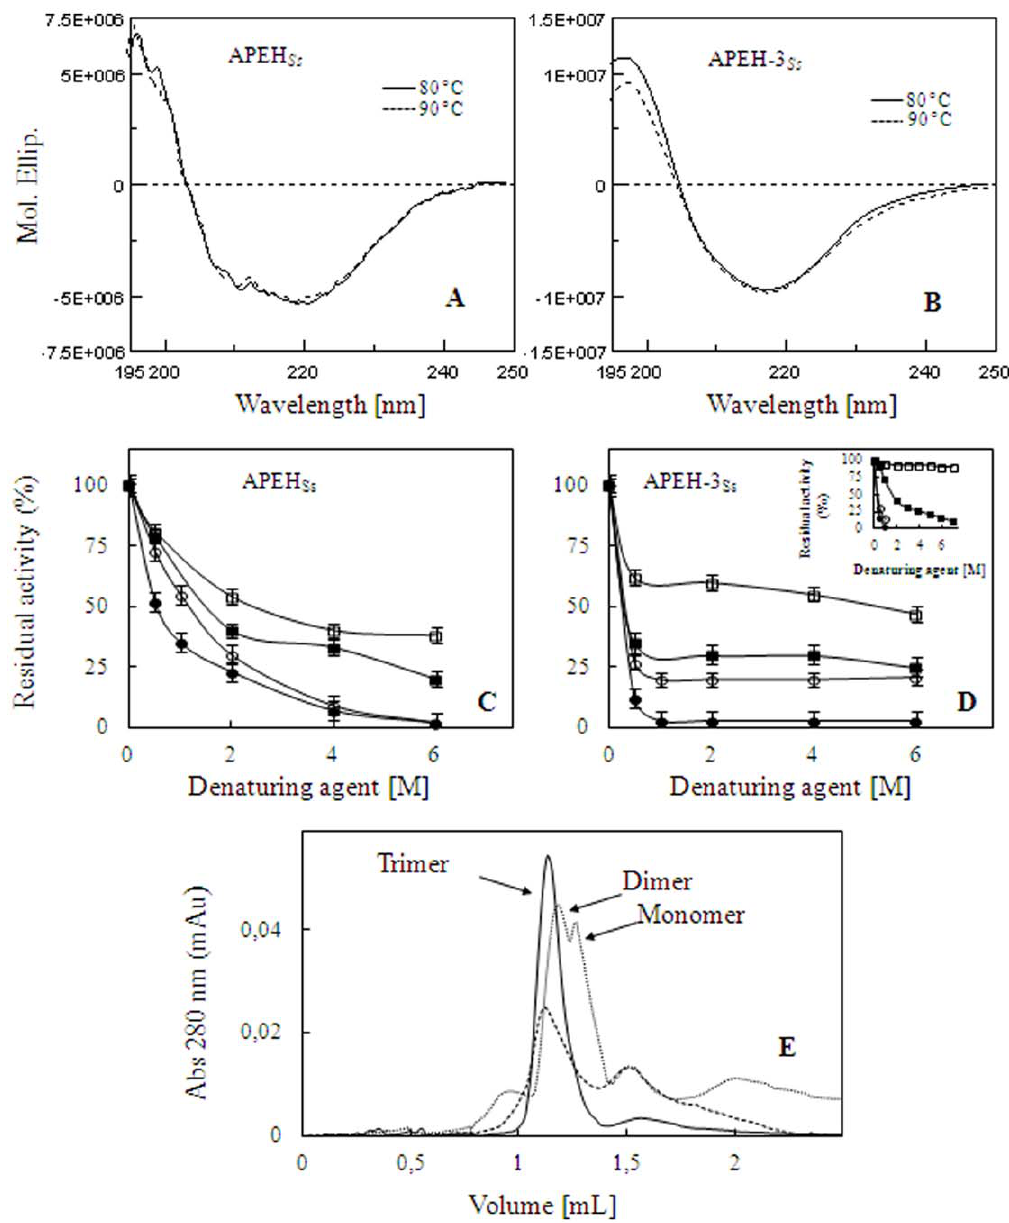
Figure 3. APEH structure and function analysis. ( A ) CD spectra performed at 80 u C and 90 u C for APEH Ss or ( B ) APEH-3 Ss , respectively. ( C ) Effect N of chaotropic agent on APEH Ss , and ( D ) APEH-3 Ss : the enzymatic activity was measured using Ac-A- p NA for APEH-3 Ss and Ac-L- p NA for APEH Ss as ); the activities were recovered after renaturation by extensive dialysis ( % ; # ); by substrates, after addition of urea ( & ) or guanidine hydrochloride ( comparison, mammalian APEH behavior [ ref 28] is shown in D insert . ( E ) Size exclusion chromatography elution profiles: native APEH-3 Ss ( __ ); APEH- 3 Ss treated with GnHCl ( NNN ); GnHCl-treated APEH-3 Ss after extensive dialysis ( --- ).